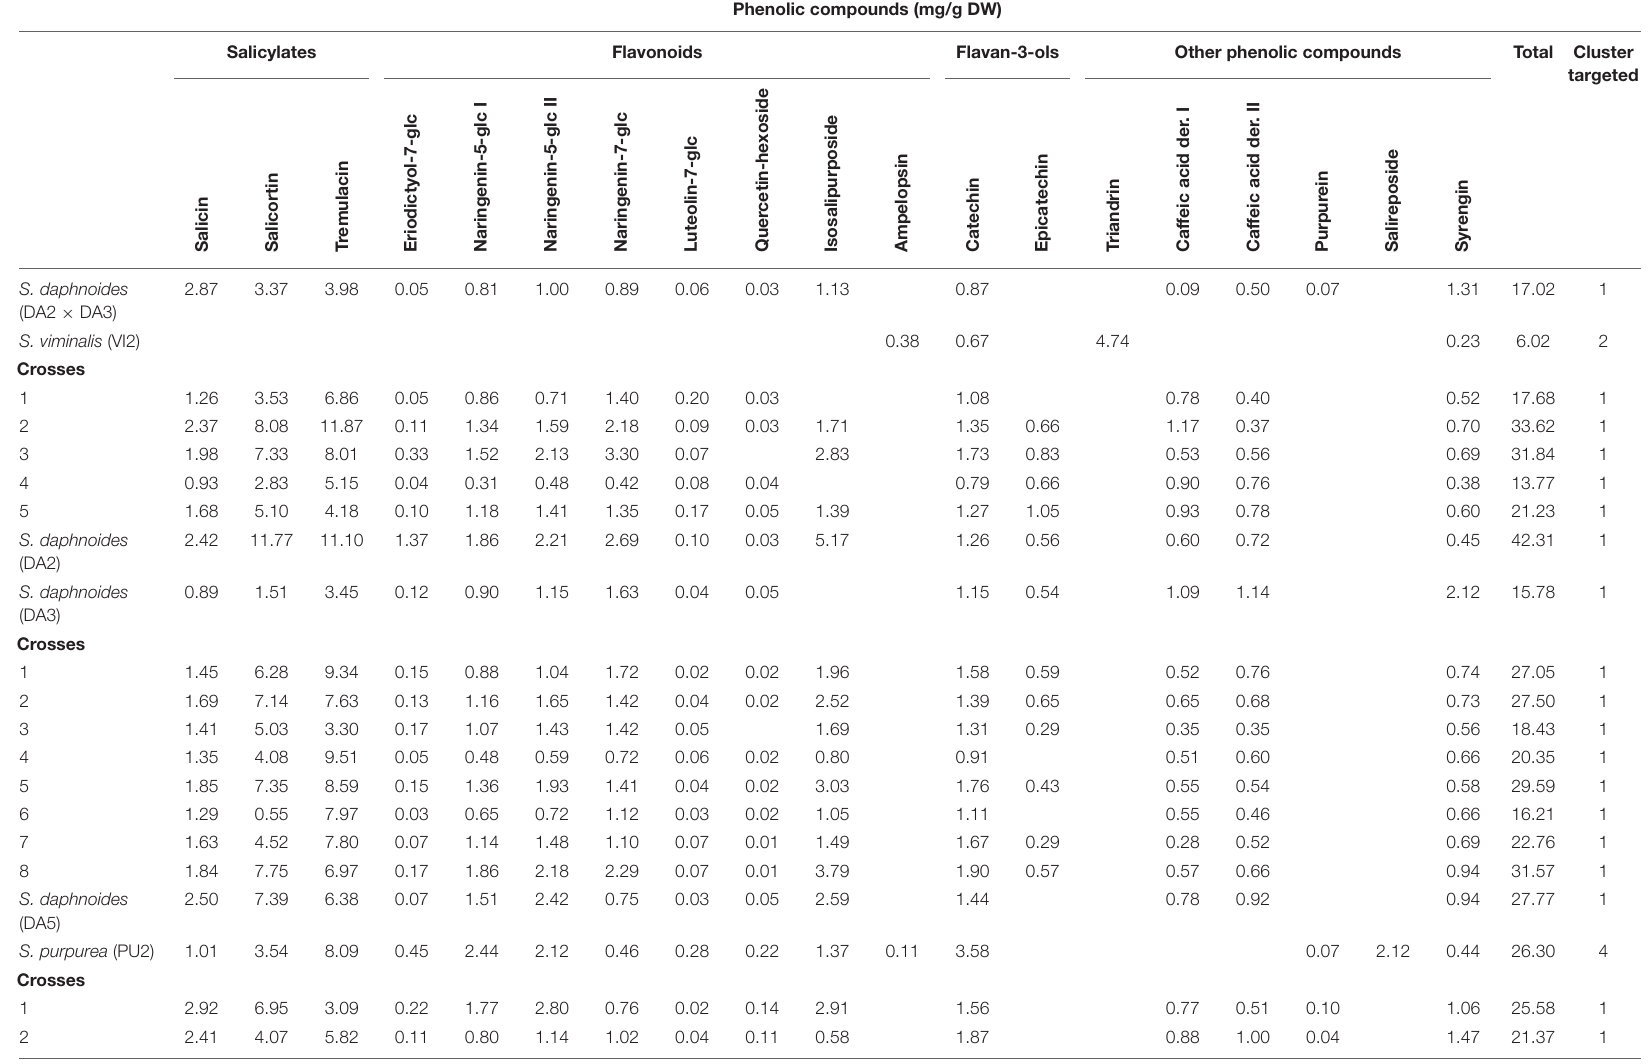
Phenolic compounds (mg/g DW)